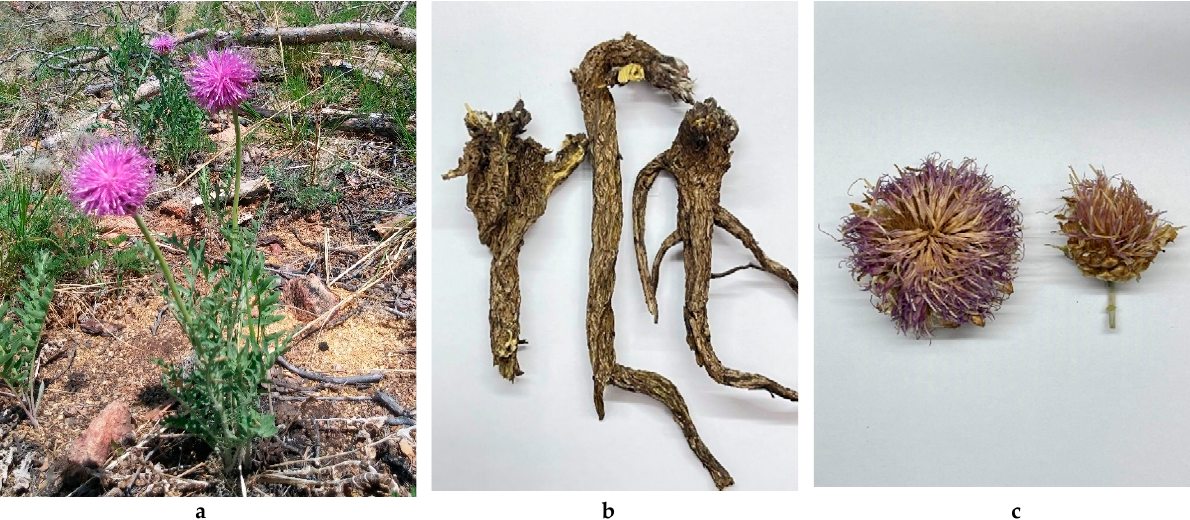
Figure 1. Rhaponticum uniflorum (L.) DC. (one-flowered leuzea) in its natural habitat (Republic Buryatia, Ivolginskii District, Kluchi vicinity, mountain slope; a ), and dried roots ( qizhou loulu ; b ) and flowers ( louluhua , spyang-tser ; c ).